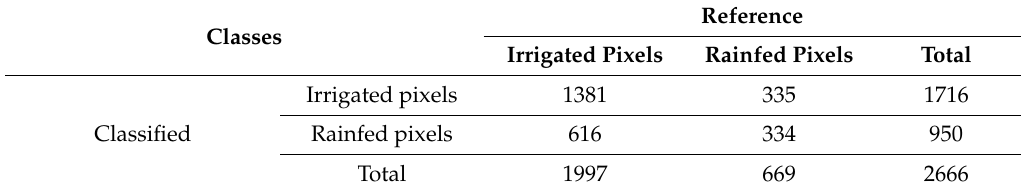
Table 3. Classification accuracy when the NDVI is assessed.